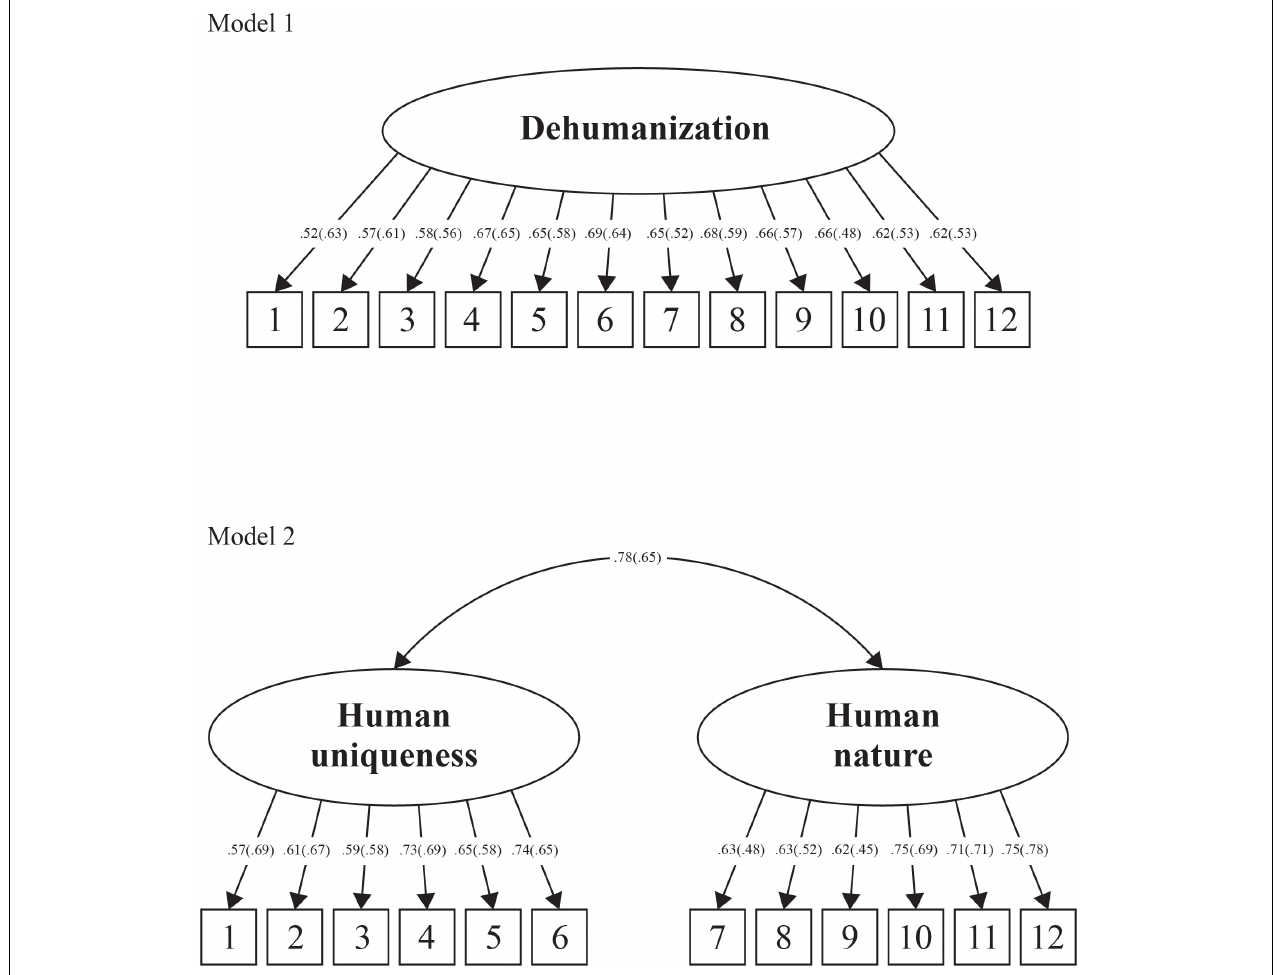
FIGURE 1 | Alternative conceptualizations of dehumanization. Standardized factor loadings and covariances for perpetration items are presented in